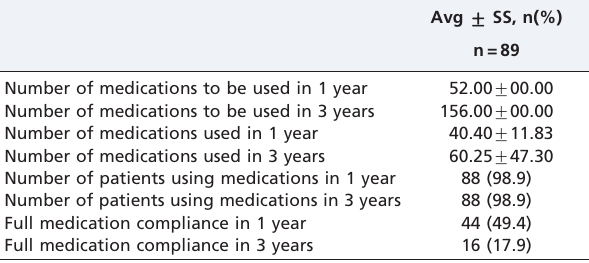
Table 2 - Distribution of data related to the treatment of patients with medications.